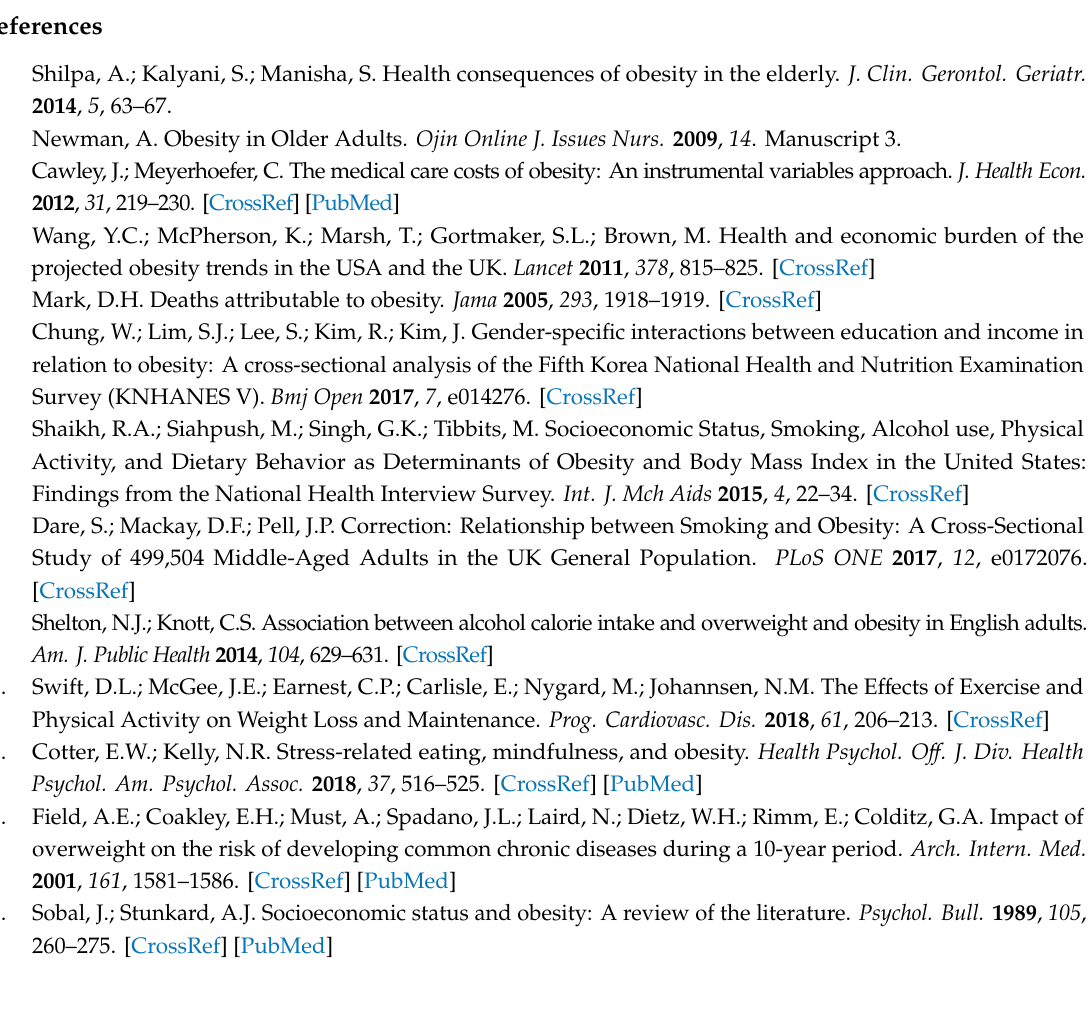
Table S1: Sample characteristics at Waves 2 to 6 by gender. Table S2: Changes in the obesity status between waves by gender (the number of participants and